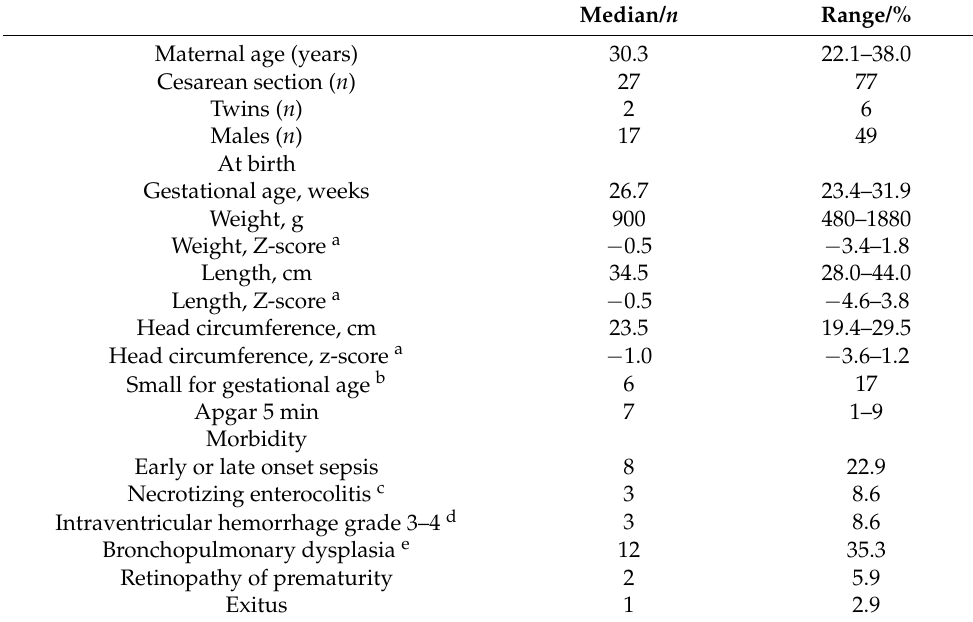
Table 1. Clinical characteristics of the 35 very preterm